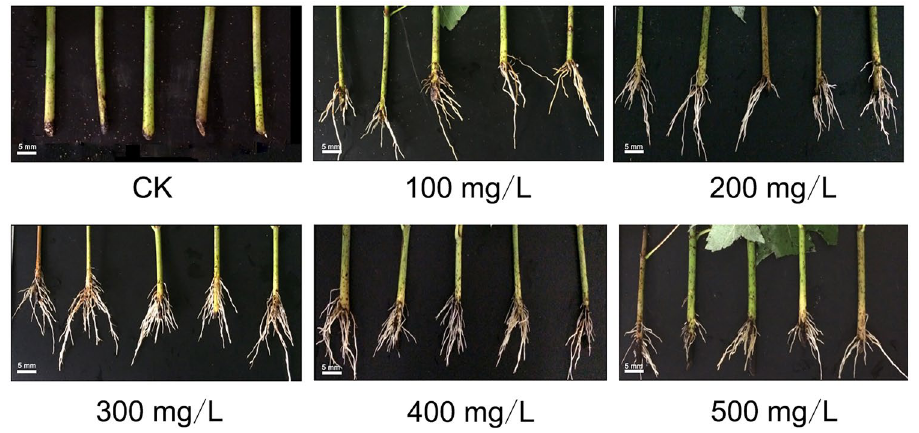
Figure 1. AR formation in A. rubrum cuttings treated with 100–500 mg/L IBA and deionized water (CK). As IBA concentration increased, the number of ARs showed a trend of increasing and then decreasing and reached a peak at IBA 300 mg/L. Scale bar, 5